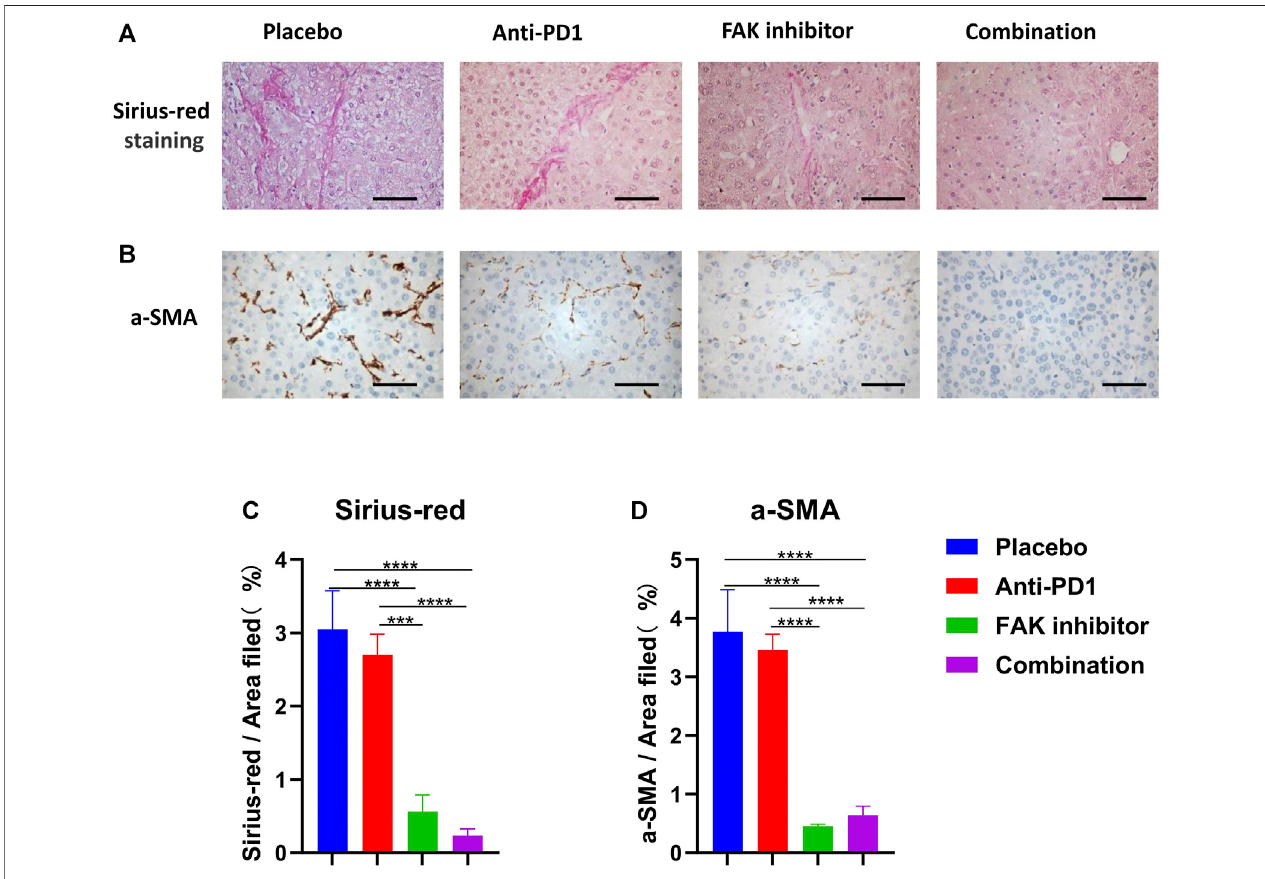
FIGURE4| FAKinhibitionreducedthe fi brosisofHCCinmice (A) Sirius-redstainingwasperformedonHCCtissuesofmiceineachgroup(scalebars,100 μ m). (B) a-SMAimmunohistochemistrywasperformedonHCCtissuesofmiceineachgroup(scalebars,100 μ m). (C) Quanti fi cationofSirius-redstaining( n (cid:1) 3mice/group). (D) Quanti fi cation of a-SMA staining ( n (cid:1) 3 mice/group). Signi fi cance identi fi cation: ns, p ≥ 0.05; *, p < 0.05; **, p < 0.01; ***, p <